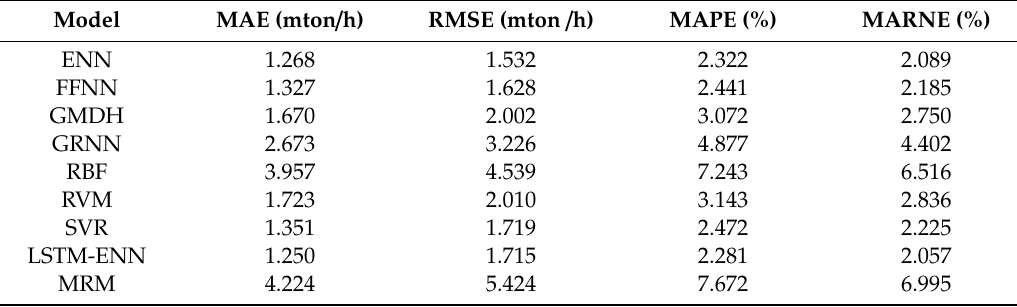
Table 9. Models comparison for Case Study